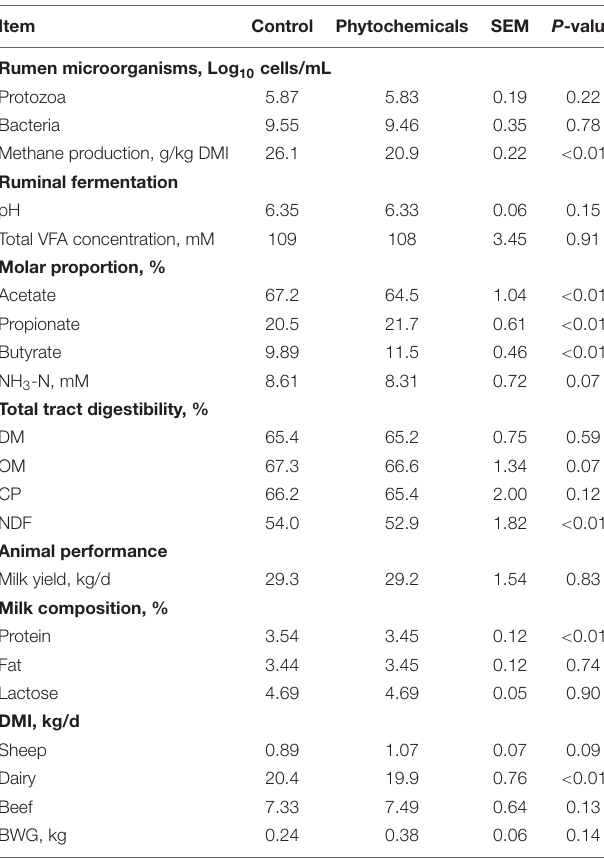
TABLE 2 | Effects of complete ruminal protozoa (RP) inhibition on ruminal microorganisms, methane production, total tract digestibility, ruminal fermentation, and animal